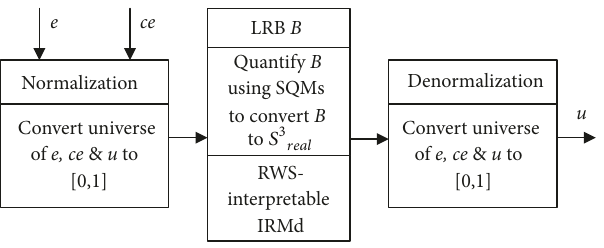
Figure 8: The components of the